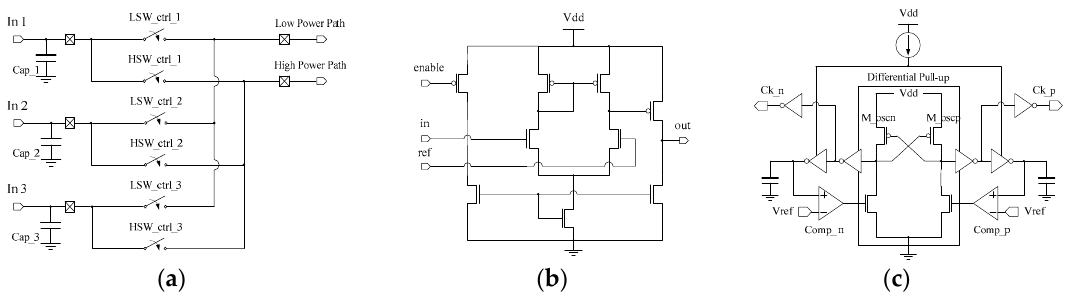
Figure 6. Low power analog blocks: ( a ) analog path switches; ( b ) comparators; and ( c )